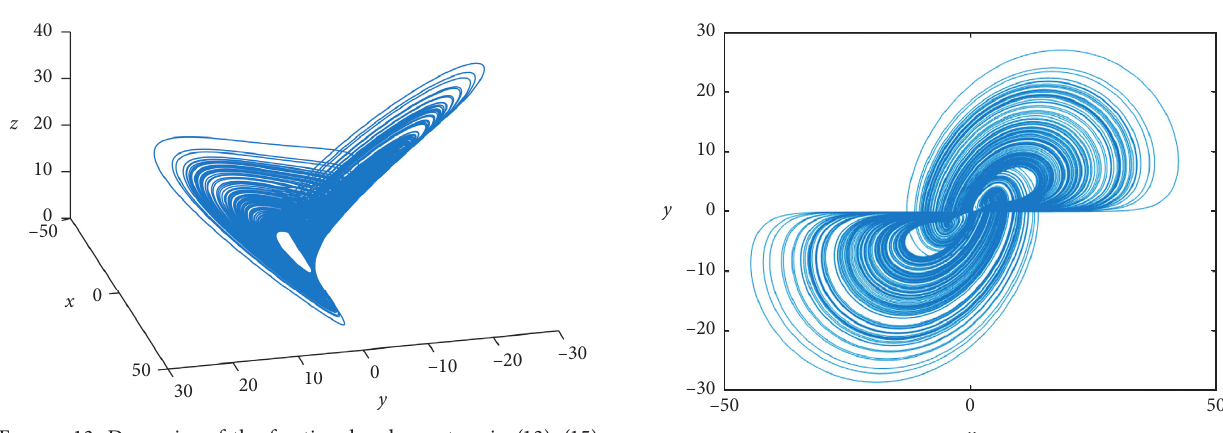
Figure 13: Dynamics of the fractional-order system in (13)–(15) with the order α � 0 . 92, in context of x , y , and z directions.